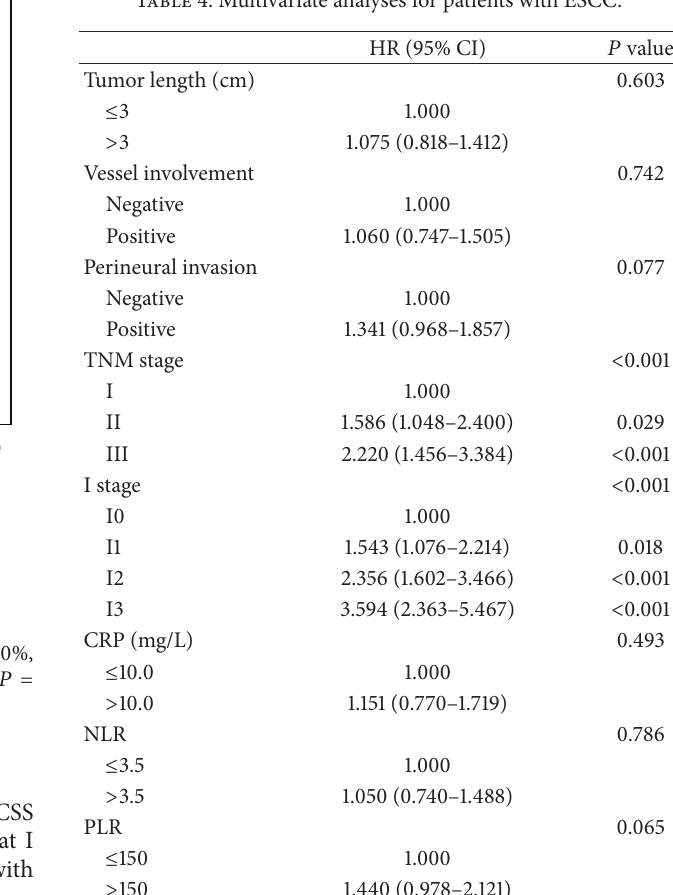
( 𝑃 < 0.001 ), and I stage ( 𝑃 < 0.001 ) were predictive of CSS